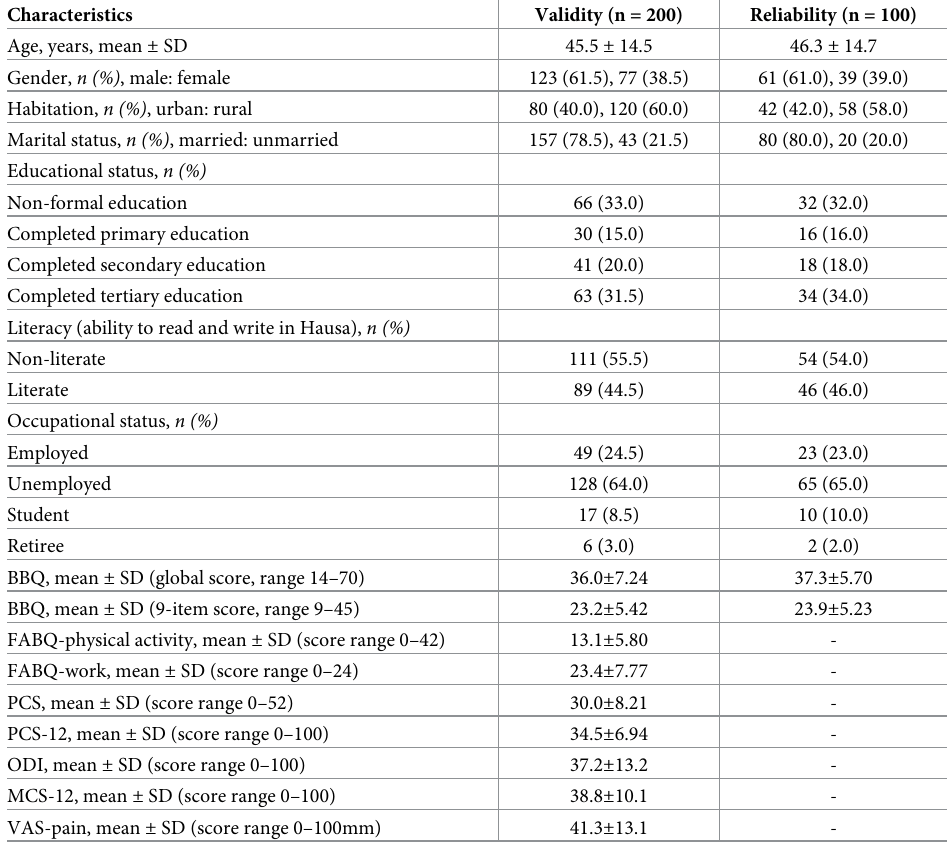
SD, standard deviation; BBQ, Back Beliefs Questionnaire; FABQ, Fear-avoidance Beliefs Questionnaire; PCS, Pain Catastrophizing Scale; ODI Oswestry Disability Index; PCS-12, Physical Component Summary; MCS-12, Mental Component Summary; VAS-pain, Visual Analogue Scale for